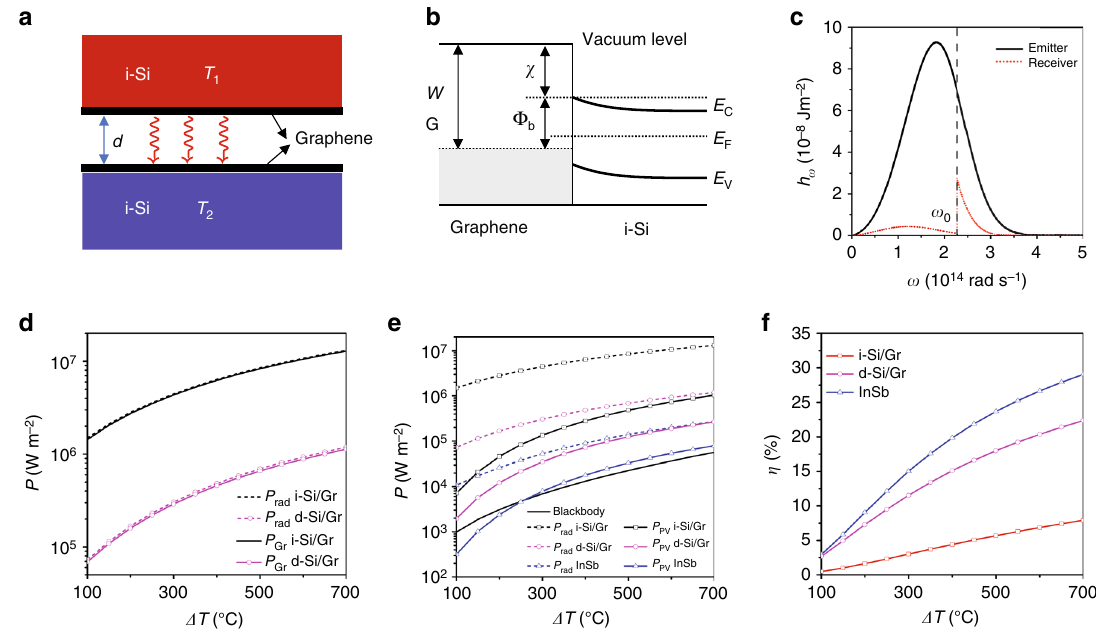
Fig. 6 Numerical analysis of the Si/Gr-based near- fi eld TPV cell. a The schematic of the TPV cell consisting of a pair of Si/Gr heterostructures. The top is emitter with temperature T 1 and the bottom is the PV cell (receiver) with temperature T 2 ( = 30 °C). The PV cell is biased to have a potential difference V b . b The interface band diagram of the n-Si/Gr Schottky diode for the PV cell. The physical parameters have been de fi ned in the main text. c The radiated near- fi eld heat fl ux spectra of emitter (black) and receiver (red) at 700 and 30 °C, respectively. High energy photons in the shaded region with ω > ω Φ = (cid:1) h could cross the barrier in the cell and contribute to the photocurrent. d The radiated power density P 0 (cid:3) b portion P Gr (solid line) solely absorbed by the graphene layer on both i-Si (black) and d-Si (pink) substrates at Δ T ranging from 100 to 700 °C. e Power density P PV of the i-Si/Gr (black), d-Si/Gr (pink) and InSb (blue) TPV cells together with their net radiation power P rad (dashed lines). The blackbody radiation power (yellow) is also given for comparison. f The corresponding power ef fi ciency η ( = P PV / P rad ) for the three cells de fi ned in e . The material parameters are speci fi ed in the Methods section. The gap is 50 nm. Figure 6 by Yang J et